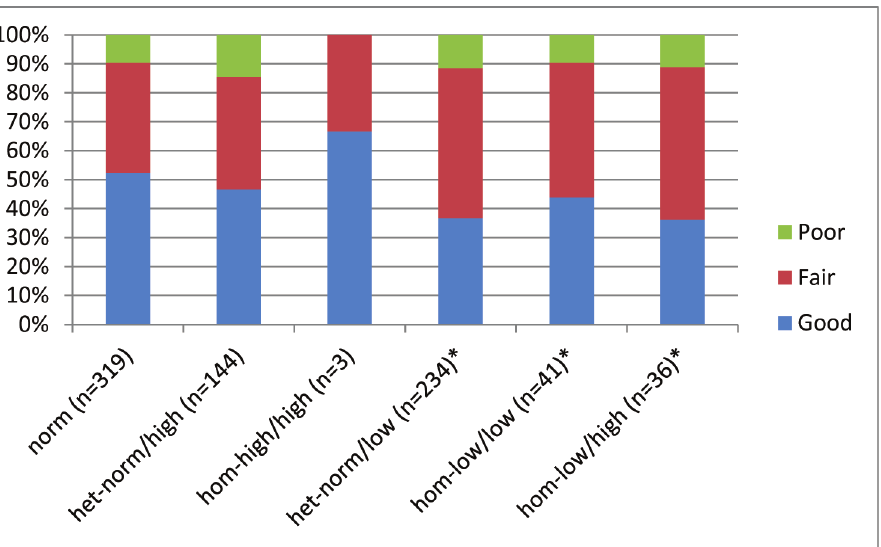
Figure 1. The distribution of morphologic embryo quality for each FMR1 sub-genotype. *Morphologic embryo quality in sub-genotypes with a low allele present was significantly reduced in comparison to those without a low allele (P=0.032). OR of chance of good vs. fair/poor embryos in absence of a low allele was 1.637.